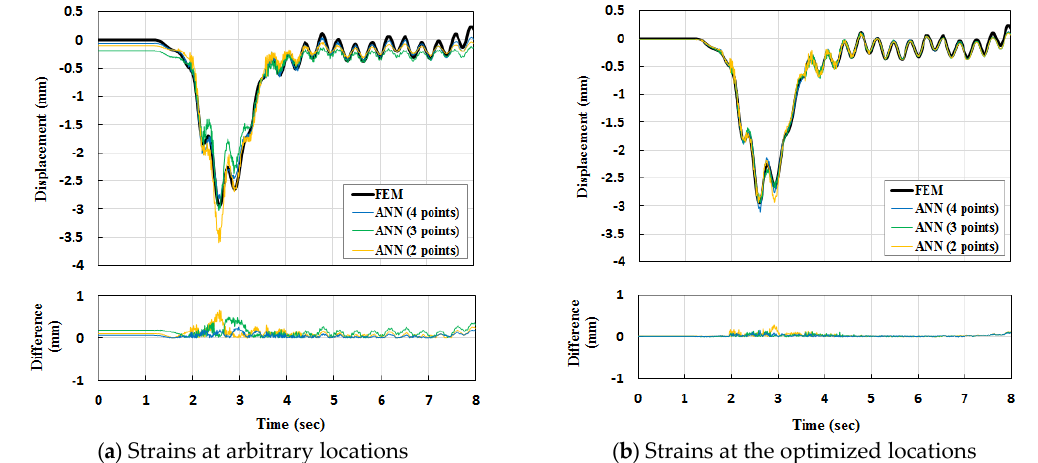
Figure 16. Overall displacements shape at t = 1.75 s (max. displacement) for the 60 km/h test dataset.